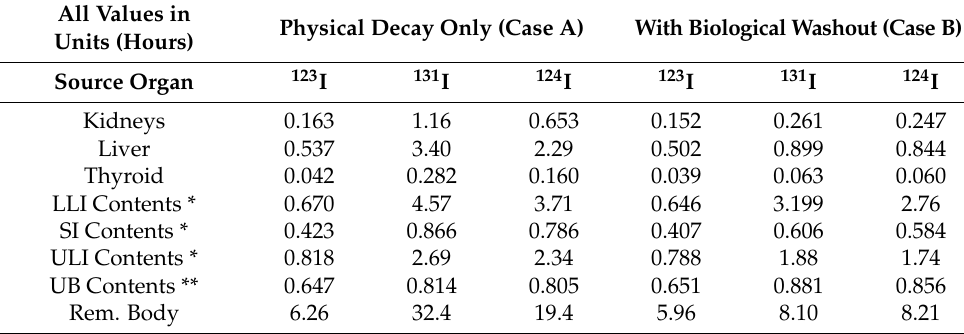
Table 3. Residence times (RT), averaged over all six volunteers, in hours. All Values